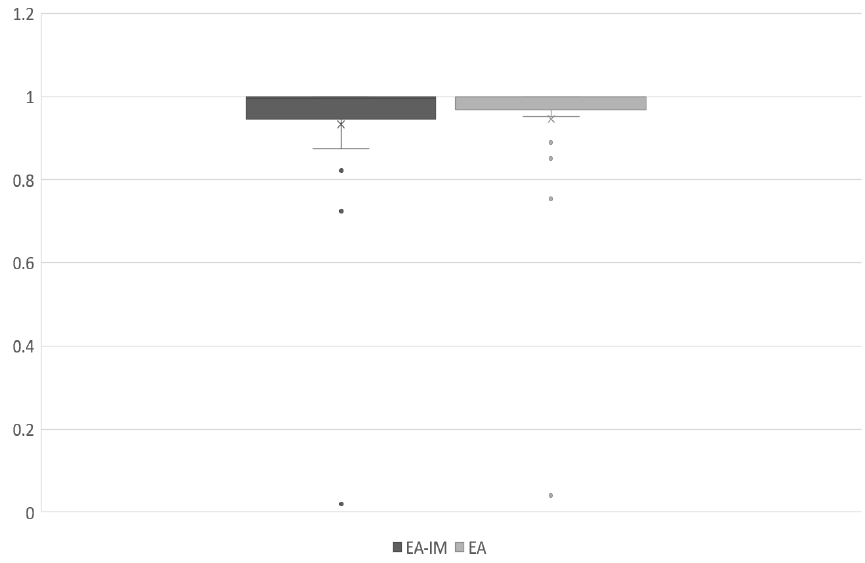
Figure 11. Comparison of EA-IM and EA on the Box-and-whisker Plot in terms of f-measure. Table 3. Comparison of EA-IM and EA in terms of Running Time